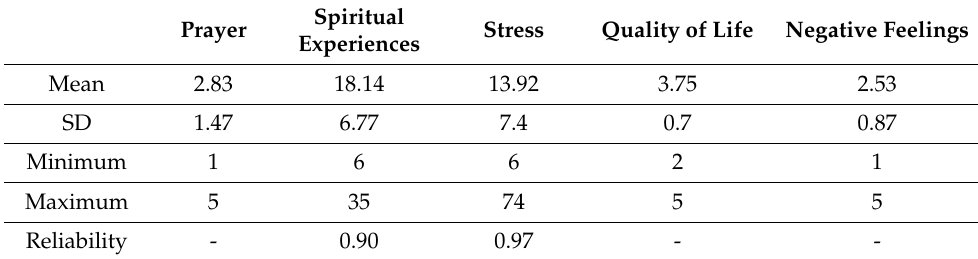
Table 1. Descriptives statistics in a sample of Chilean students ( n = 177).